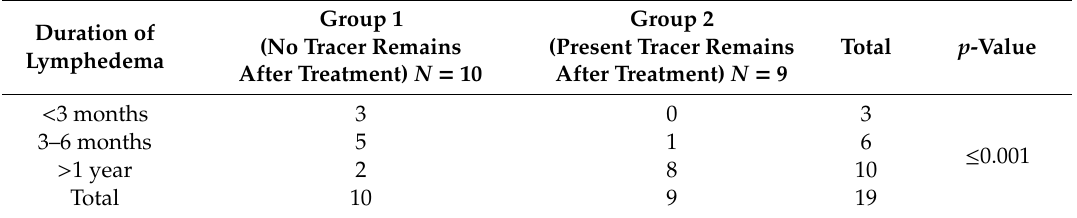
Table 1. Relationship in absolute frequencies, between the time of duration of the lymphedema and the visibility of the indocyanine green (ICG) tracer.